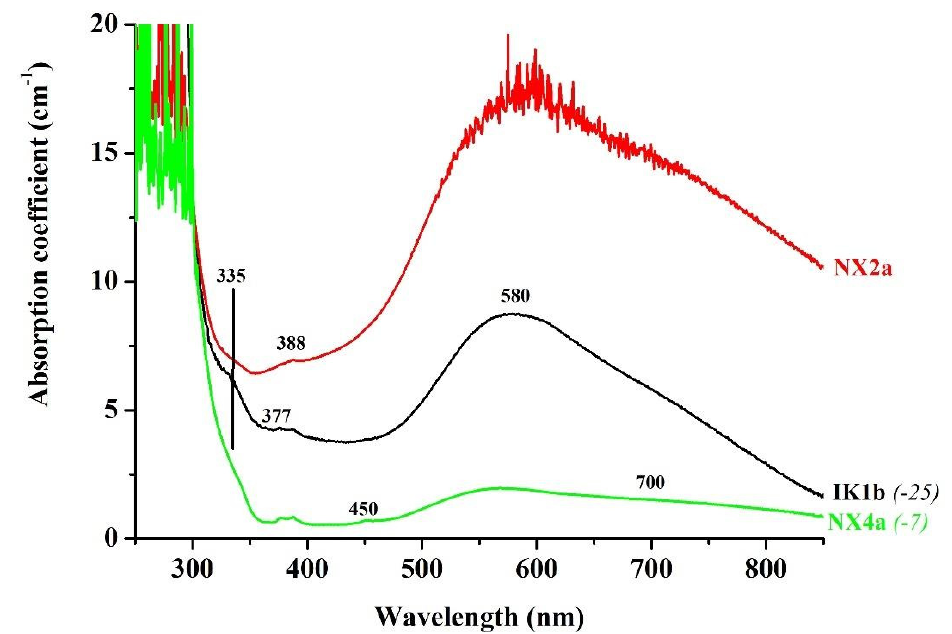
Figure 9. UV-Vis spectra of sapphires from Ikaria and (Kinidaros) Naxos islands; IK1b (black trace), NX2a (red trace) and NX4a (green trace). Black and green spectra are shifted vertically (value in parenthesis) for clarity.